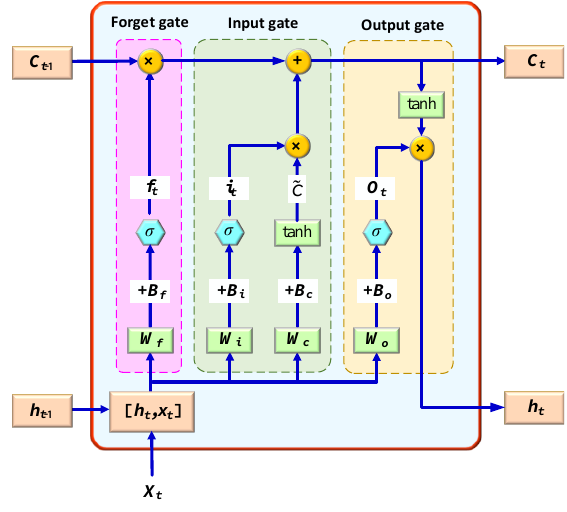
Figure 1. Structure of LSTM.